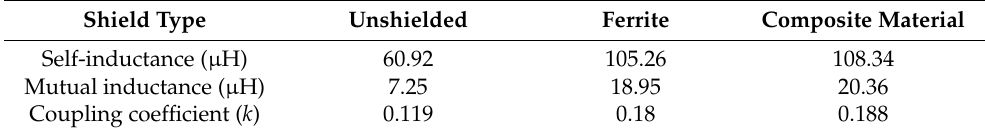
Table 3. Coil inductance measurement results.